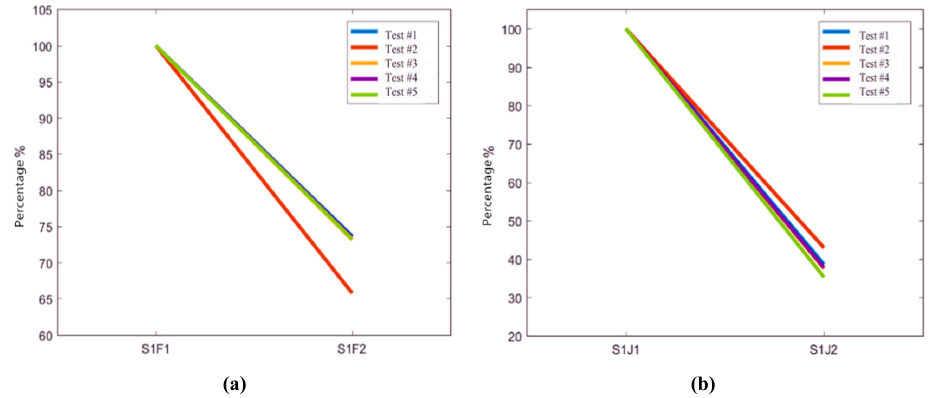
Figure 11. Vibration transfer rules of track slabs. ( a ) Virtual vibration value of measuring sensors on track slab in Condition #1; ( b ) Virtual vibration value of measuring sensors on track slab in Condition #2.